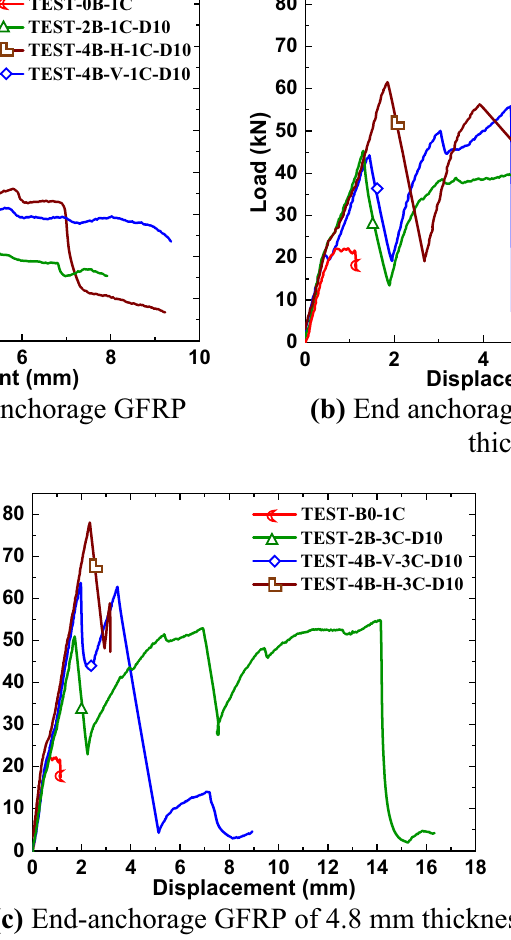
Fig. 4 Typical load versus mid-span deflection curves with variation in position of